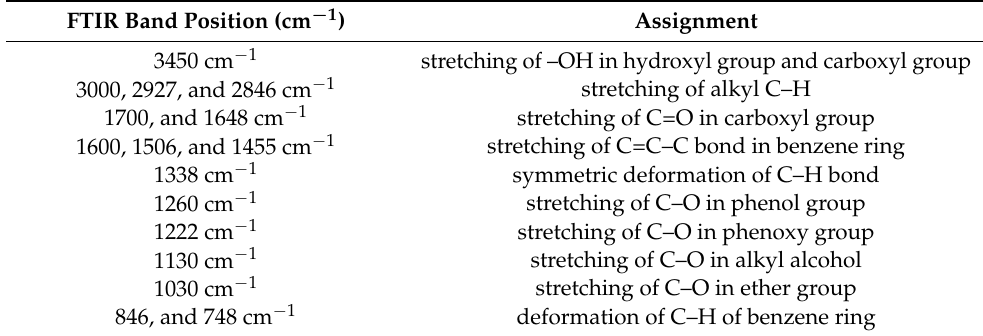
Figure 1. Fourier transform infrared spectroscopy (FTIR) spectrum of the pristine lignin, DMAP- lignin epoxide, and BTEAC-lignin epoxide. Table 4. Vibrational modes for FTIR absorbance peaks of lignin. Table 4. Vibrational modes for FTIR absorbance peaks of lignin.